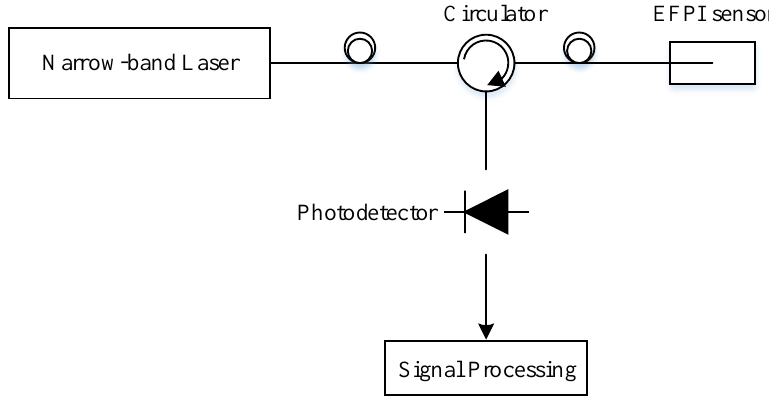
Figure 2. Schematic of intensity demodulation system.